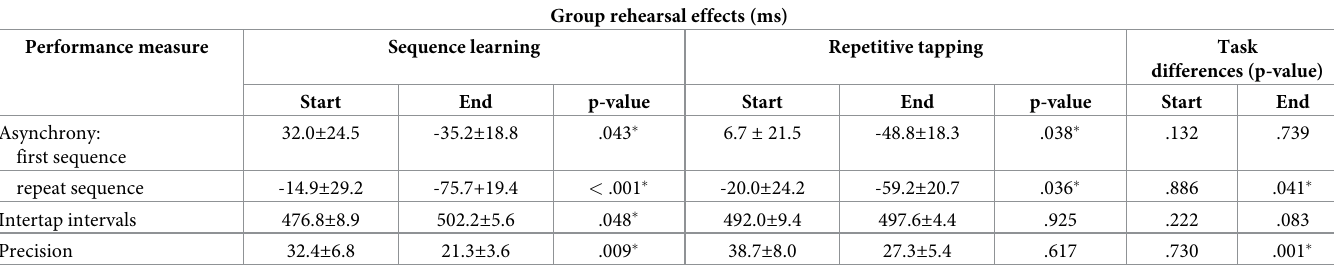
Table 1. Group rehearsal effects during sequence learning and repetitive tapping.